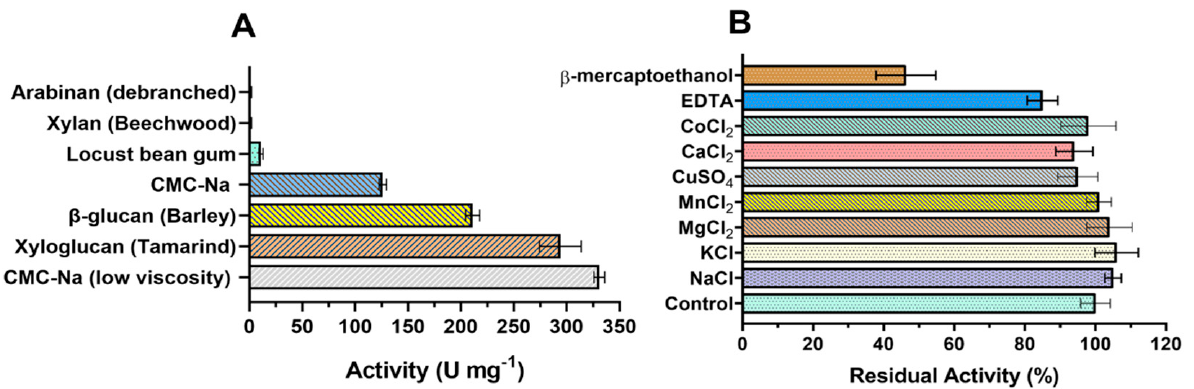
Figure 5. ( A ) Substrate specificity of the endoglucanase GH7 from T. terrestris ( Tt Cel7B). ( B ) Effect of different ions and compounds on Tt Cel7B activity against medium-viscosity CMC-Na.